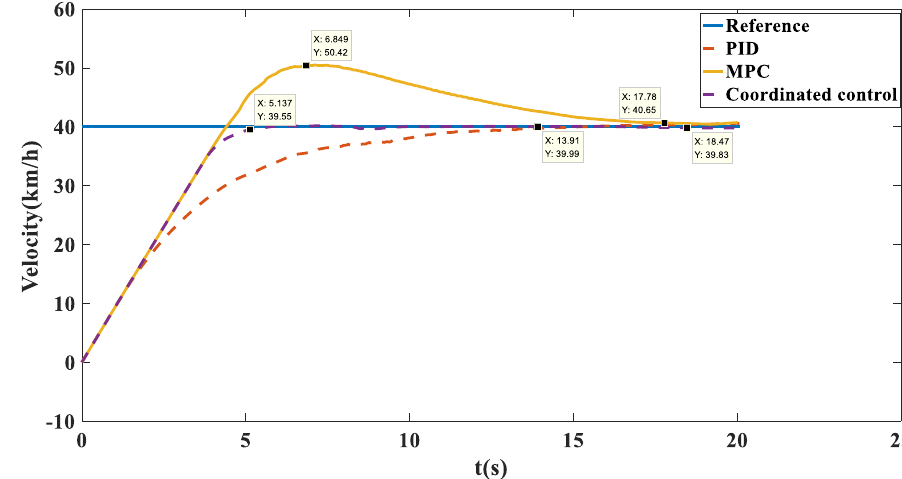
Figure 17. Path tracking comparison chart on the sine sweep straight road.